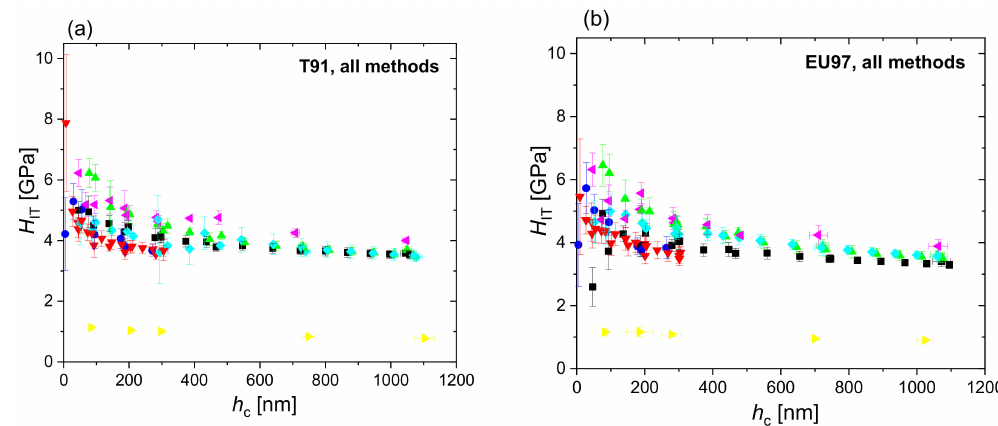
Figure 3. Indentation hardness, H IT , of T91 ( a ) and Eurofer97 ( b ) measured at the di ff erent laboratories for all methods combined (FSC, DSC and